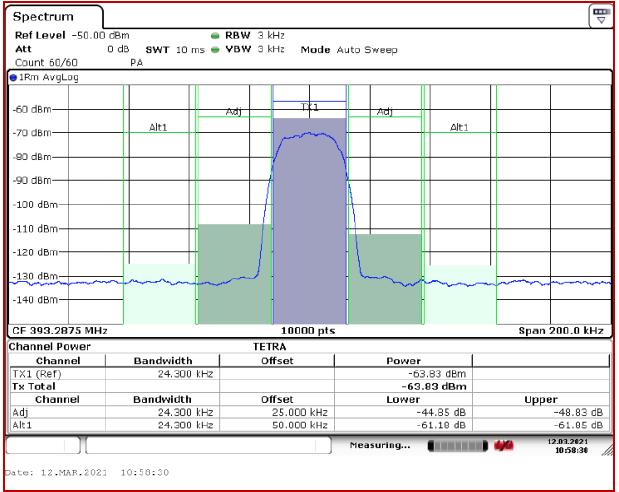
Figure 13. Adjacent channel attenuation measured by R&S FSV13